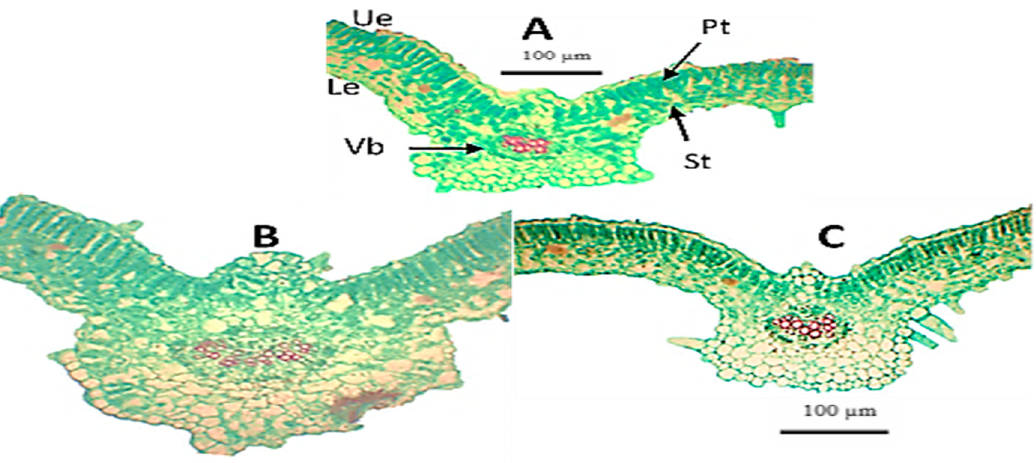
Figure 3. Effect of plant growth promoting rhizobacteria (PGPR) and cyanobacteria on the terminal leaflet characteristics of tomato as comparing to the untreated plants (control).